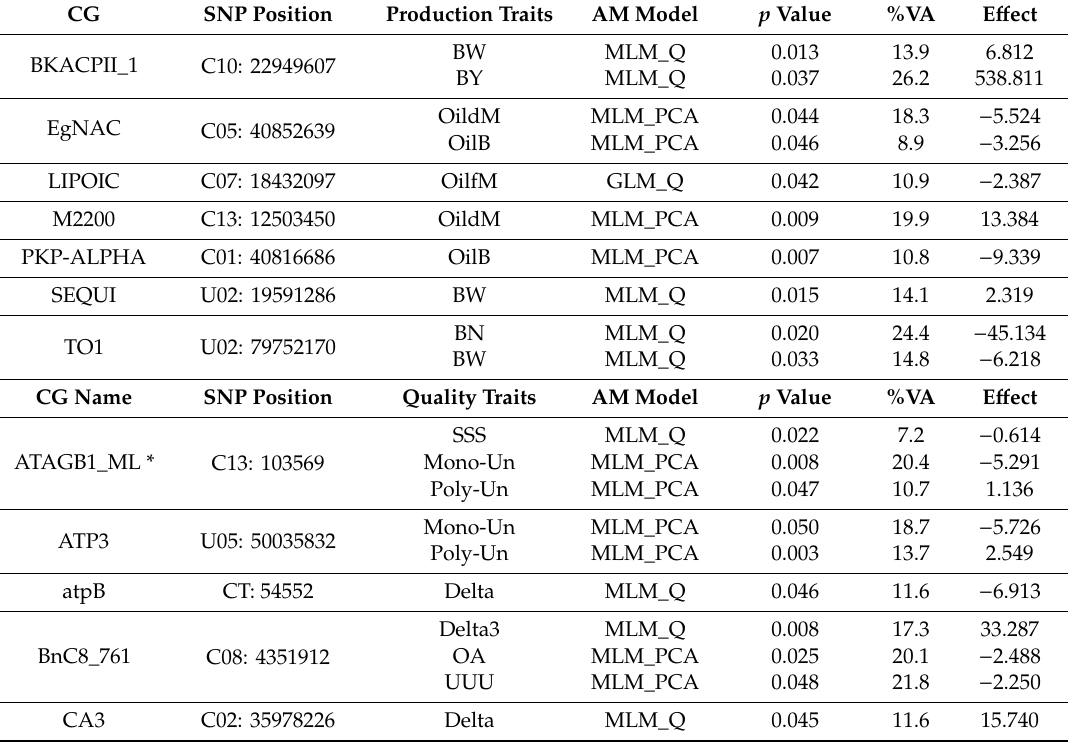
Table 4. Results of association mapping between CG Single nucleotide polymorphisms (SNP) and production and oil quality traits in oil palm